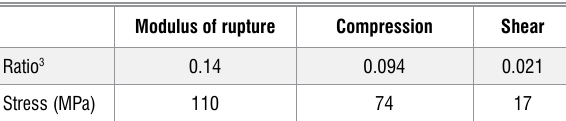
Rule-of-thumb ratios according to Janssen 3 and resulting stresses for mechanical properties of bamboo (assuming an average density of 783 kg/m 3 ) Modulus of rupture Compression Shear 0.14